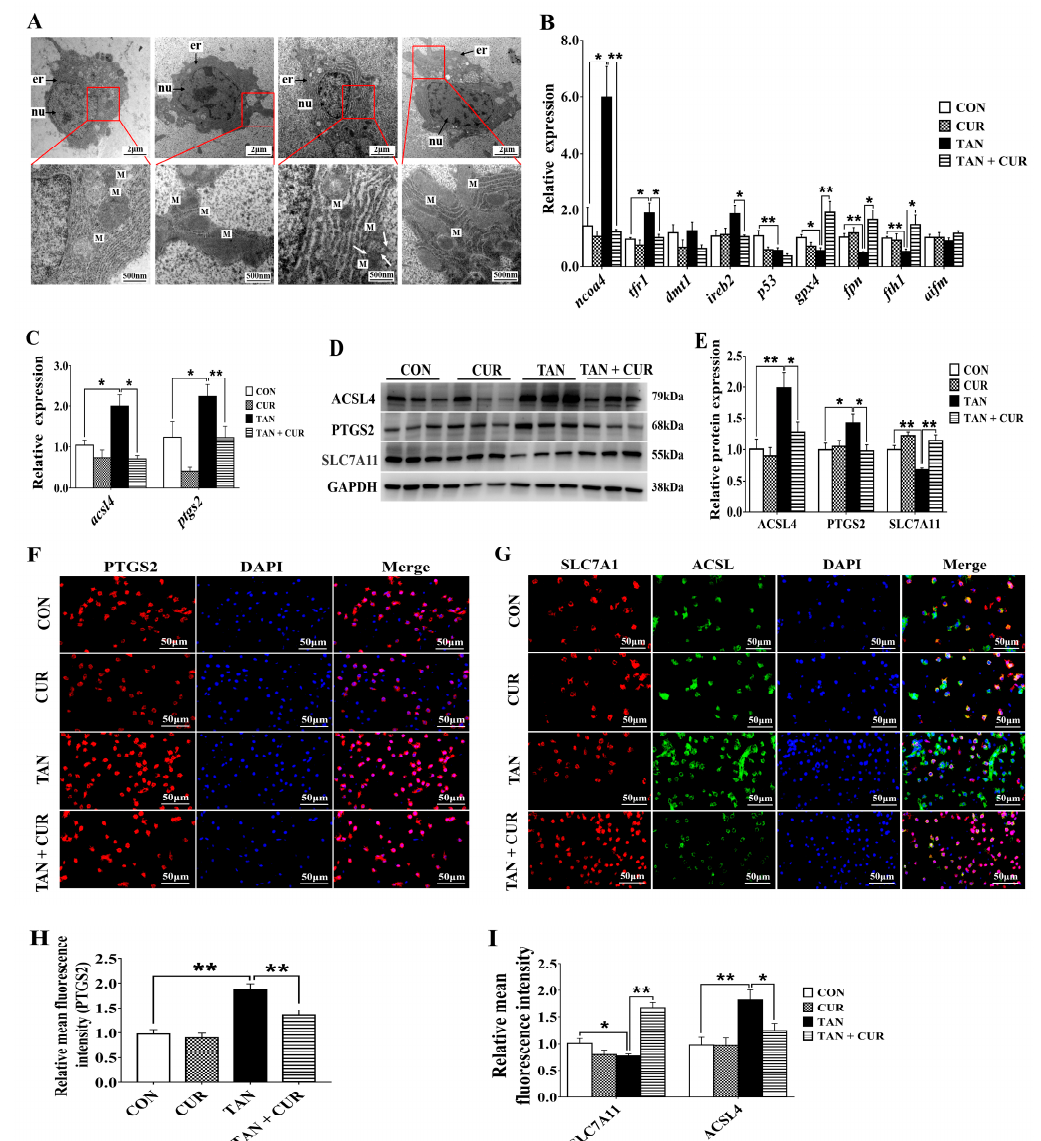
Figure 5. The ferroptosis caused by acute ammonia stress was reduced in gibel carp after feeding CUR diet for eight weeks. CON—control; CUR—curcumin; TAN—total ammonia nitrogen; TAN + CUR—total ammonia nitrogen + curcumin. ( A ) Ultrastructure (Transmission Electron Microscopy (TEM); the white arrow points to the rupture of the mitochondrial outer membrane); M—mitochondria; nu—nucleus; er—endoplasmic reticulum. ( B ) mRNA levels of ferroptosis-related genes. ncoa4 —nuclear receptor coactivator 4; tfr1 —transferrin receptor 1; dmt1 —divalent metal transporter 1; ireb2 —iron-responsive element-binding protein 2; p53 —cellular tumor antigen; gpx4 —glutathione peroxidase 4; fpn —ferroportin; fth1 —ferritin heavy chain 1; aifm2 —apoptosis-inducing factor mitochondria- associated 2. ( C ) mRNA levels of acsl4 and ptgs2. ptgs2 —prostaglandin-endoperoxide synthase 2; acsl4 —long chain acyl CoA synthetase 4. ( D ) Ferroptosis key protein expression. ( E ) Relative strength of proteins involved in ferroptosis. ( F ) Fluorescence intensity of PTGS2 (red colour) by immunoflu- orescence assay. Nuclei were stained with DAPI (blue color). scale bar = 50 µ m. ( G ) Fluorescence intensity of SLC7A11 (red color) and ACSL4 (green color) by immunofluorescence assay. Nuclei were stained with DAPI (blue color). scale bar = 50 µ m. ( H ) Quantification of PTGS2 fluorescence intensity. ( I ) Quantification of SLC7A11 and ACSL4 fluorescence intensity. The values are expressed as the mean ± standard error ( n = 6). * p < 0.05; ** p <